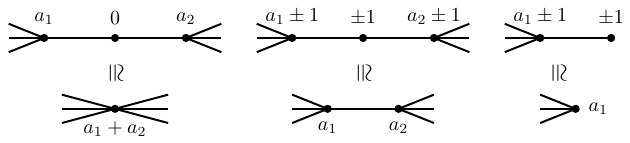
Figure 10 . 3d Kirby moves for plumbed manifolds. The resulting plumbed manifolds M and M 0 are